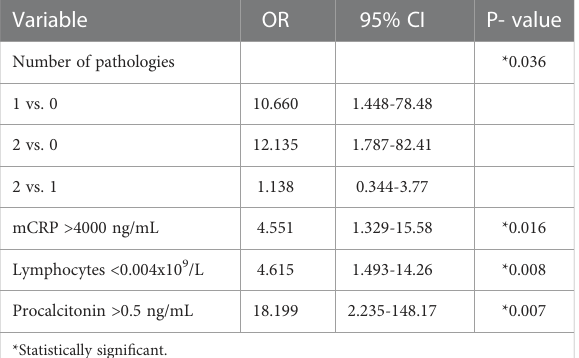
TABLE 2 Signi fi cant risk factors for disease severity (ICU admission and/or in-hospital mortality) on multivariate regression